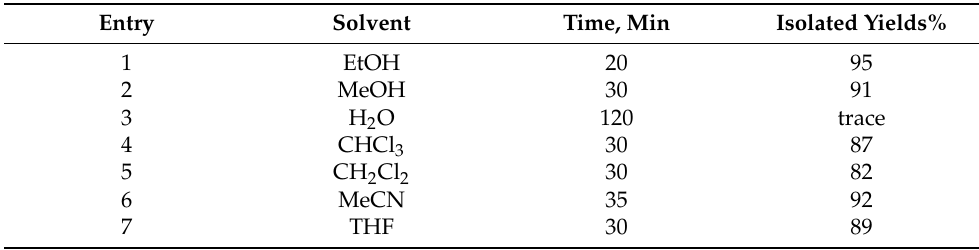
Table 2. The effects of different solvents on the reaction of benzene-1,2-diamine with benzil in the presence of bentonite clay K-10 at room